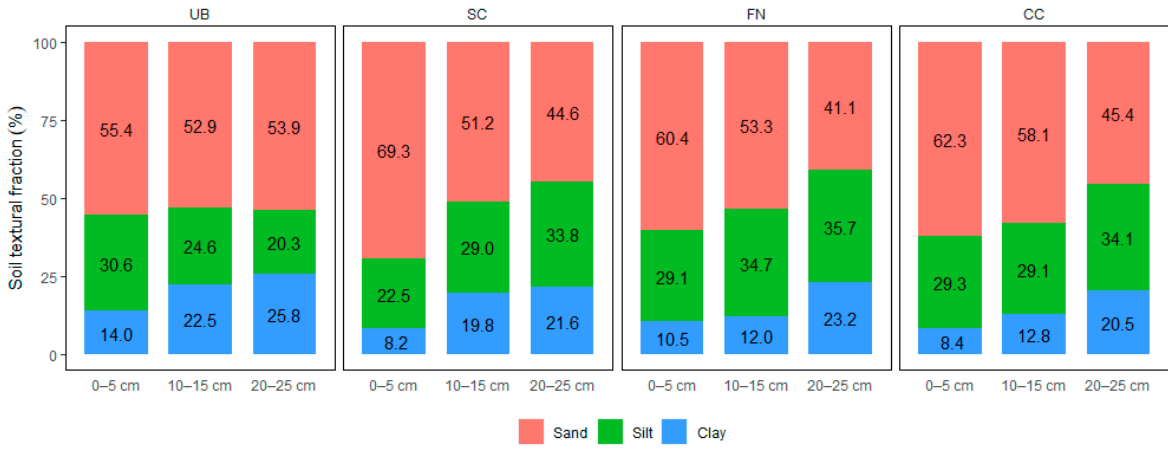
Figure 3. Variations of mean ( n = 3) soil textural fractions (%) with vegetation burn severity (UB, SC, FN, CC).